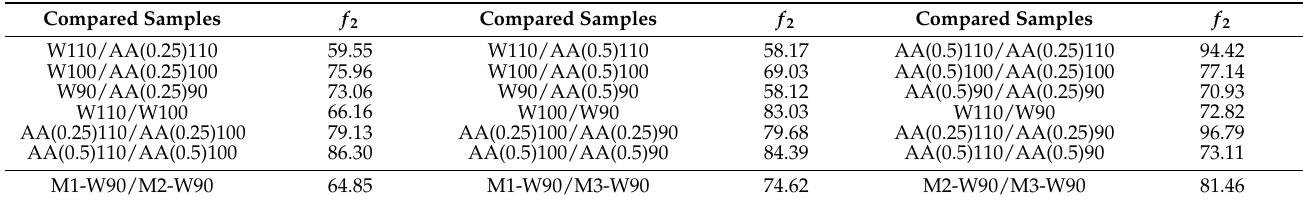
Table 3. Similarity factor analysis of uncoated